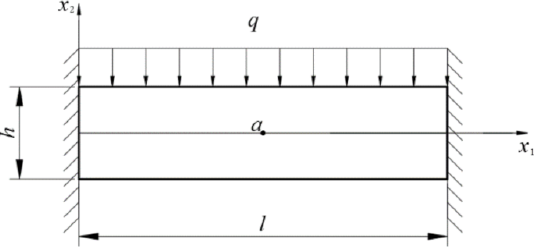
Figure 1. Clamped-clamped beam subjected to uniform